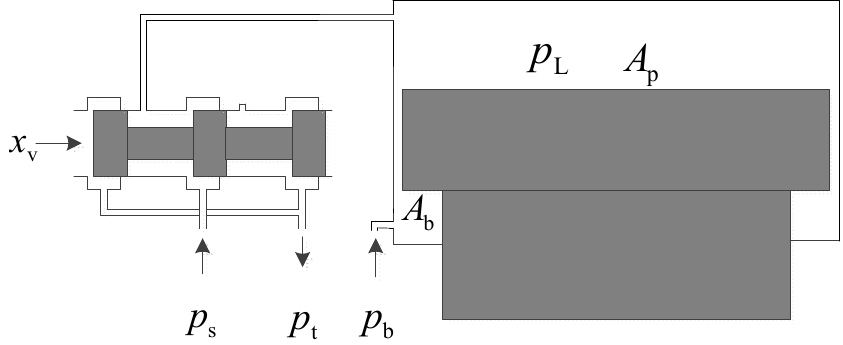
Figure 3. Hydraulic principle diagram of hydraulic screw down system.